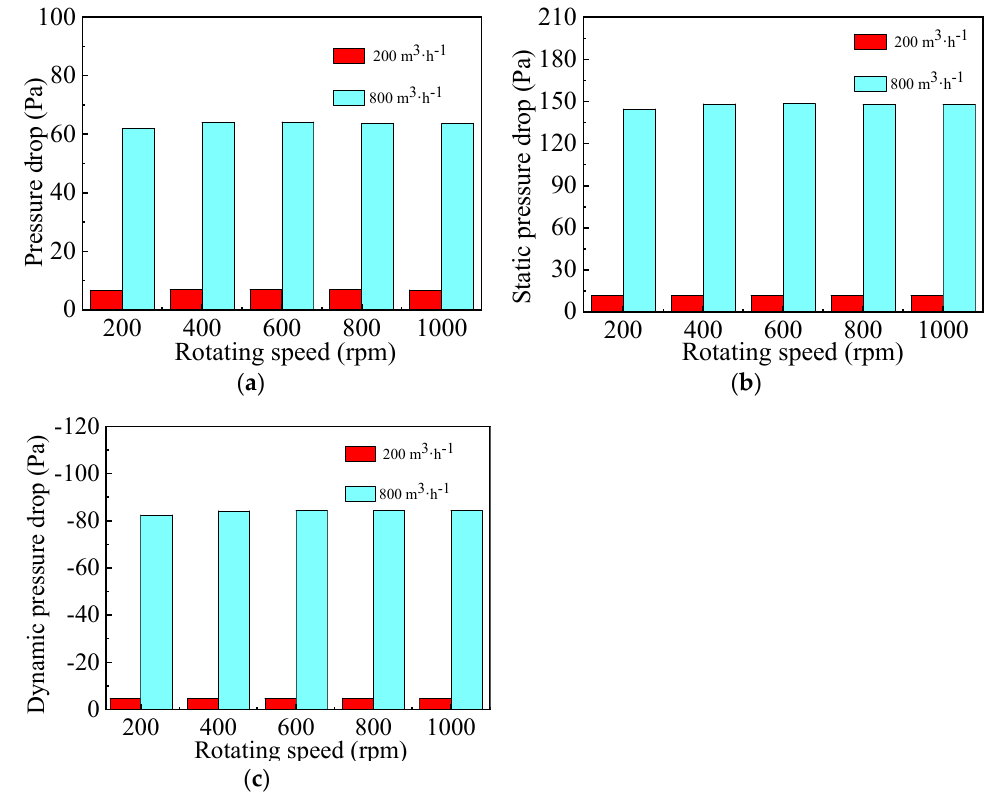
Figure 13. The effect of rotating speed on the pressure drop in the outlet zone. ( a ) Pressure drop; ( b ) static pressure drop; ( c ) dynamic pressure drop.